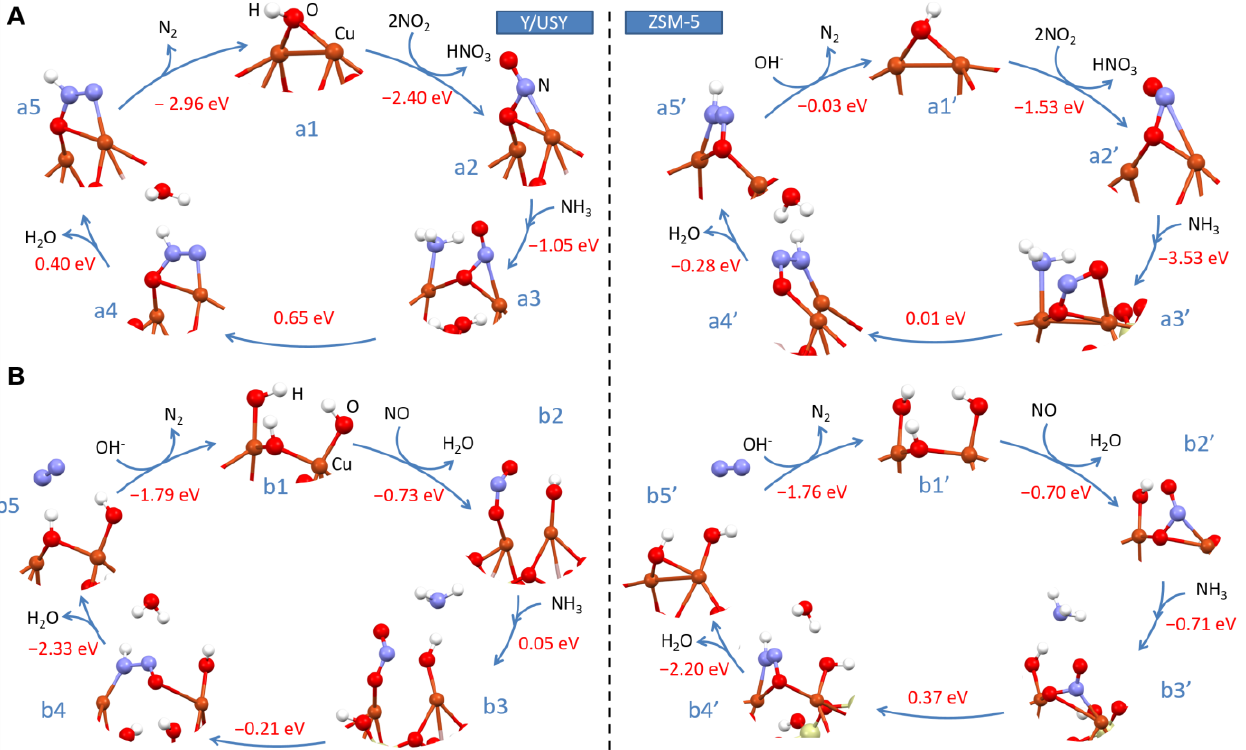
Figure 8. Proposed mechanism of deNO x at the Cu 2 O dimer supported on ( A ) partly hydrated copper dimer and ( B ) the fully hydrated copper dimer. Left column: Y/USY, right column: ZSM-5.